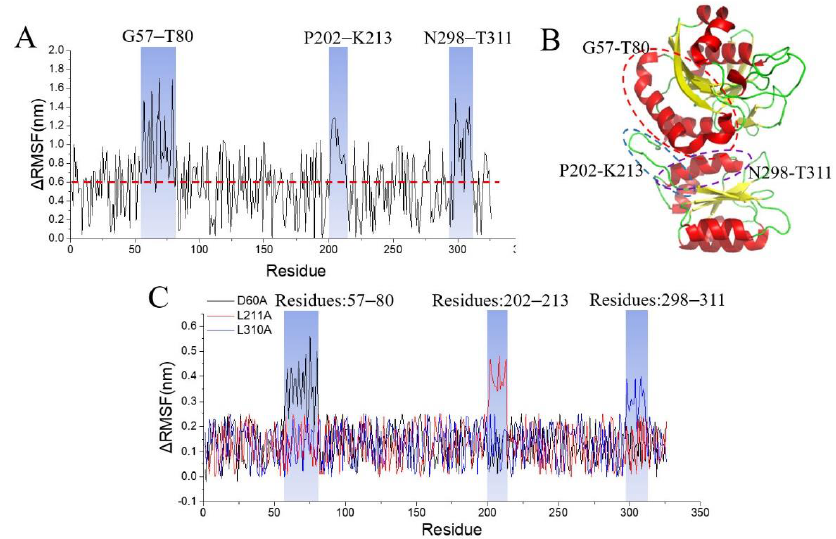
Figure 1. Molecular dynamics simulation and structural analysis of ECA. ( A ) RMSF value of ECA at 37 °C and 50 °C. ( B ) Stability key domains in ECA tertiary structure. G57- T80: the α -helix in red- at 37 ◦ C and 50 ◦ C. ( B ) Stability key domains in ECA tertiary structure. G57-T80: the α -helix in dashed box; P202-K213: the loop in blue-dashed box; N298- T311: the α -helix in purple-dashed box. red-dashed box; P202-K213: the loop in blue-dashed box; N298-T311: the α -helix in purple-dashed ( C ) ECA RMFS with “alanine scanning” . box. ( C ) ECA RMFS with “alanine